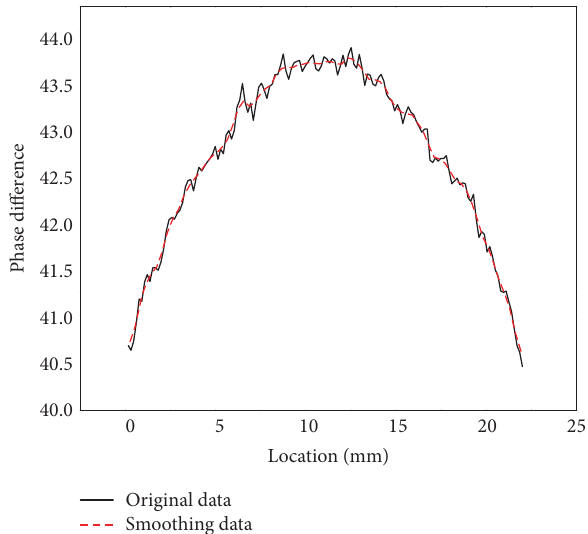
Figure 7: Phase difference of different layers of monolayer directional PMMA.